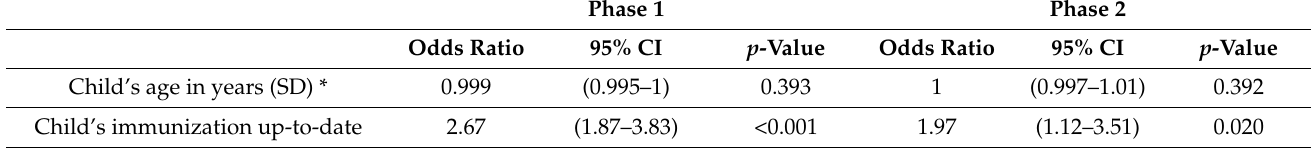
Table 4. Predictors of willingness to vaccinate against COVID-19 among caregivers of children under 12 years, identified